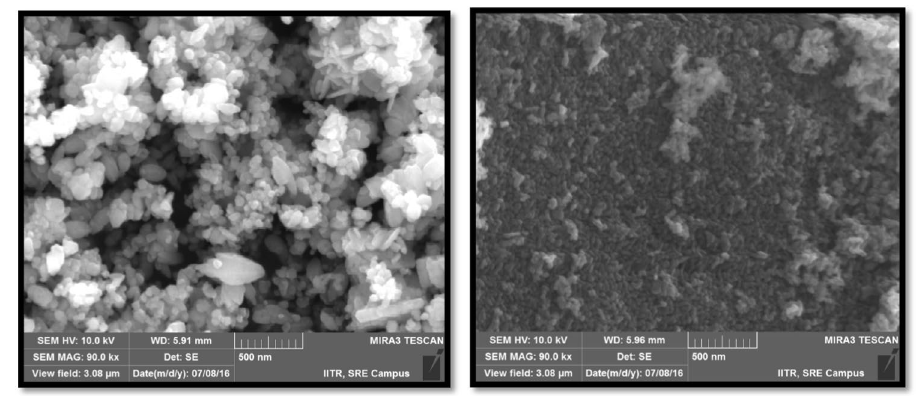
Fig. 4 SEM images of (i) zinc